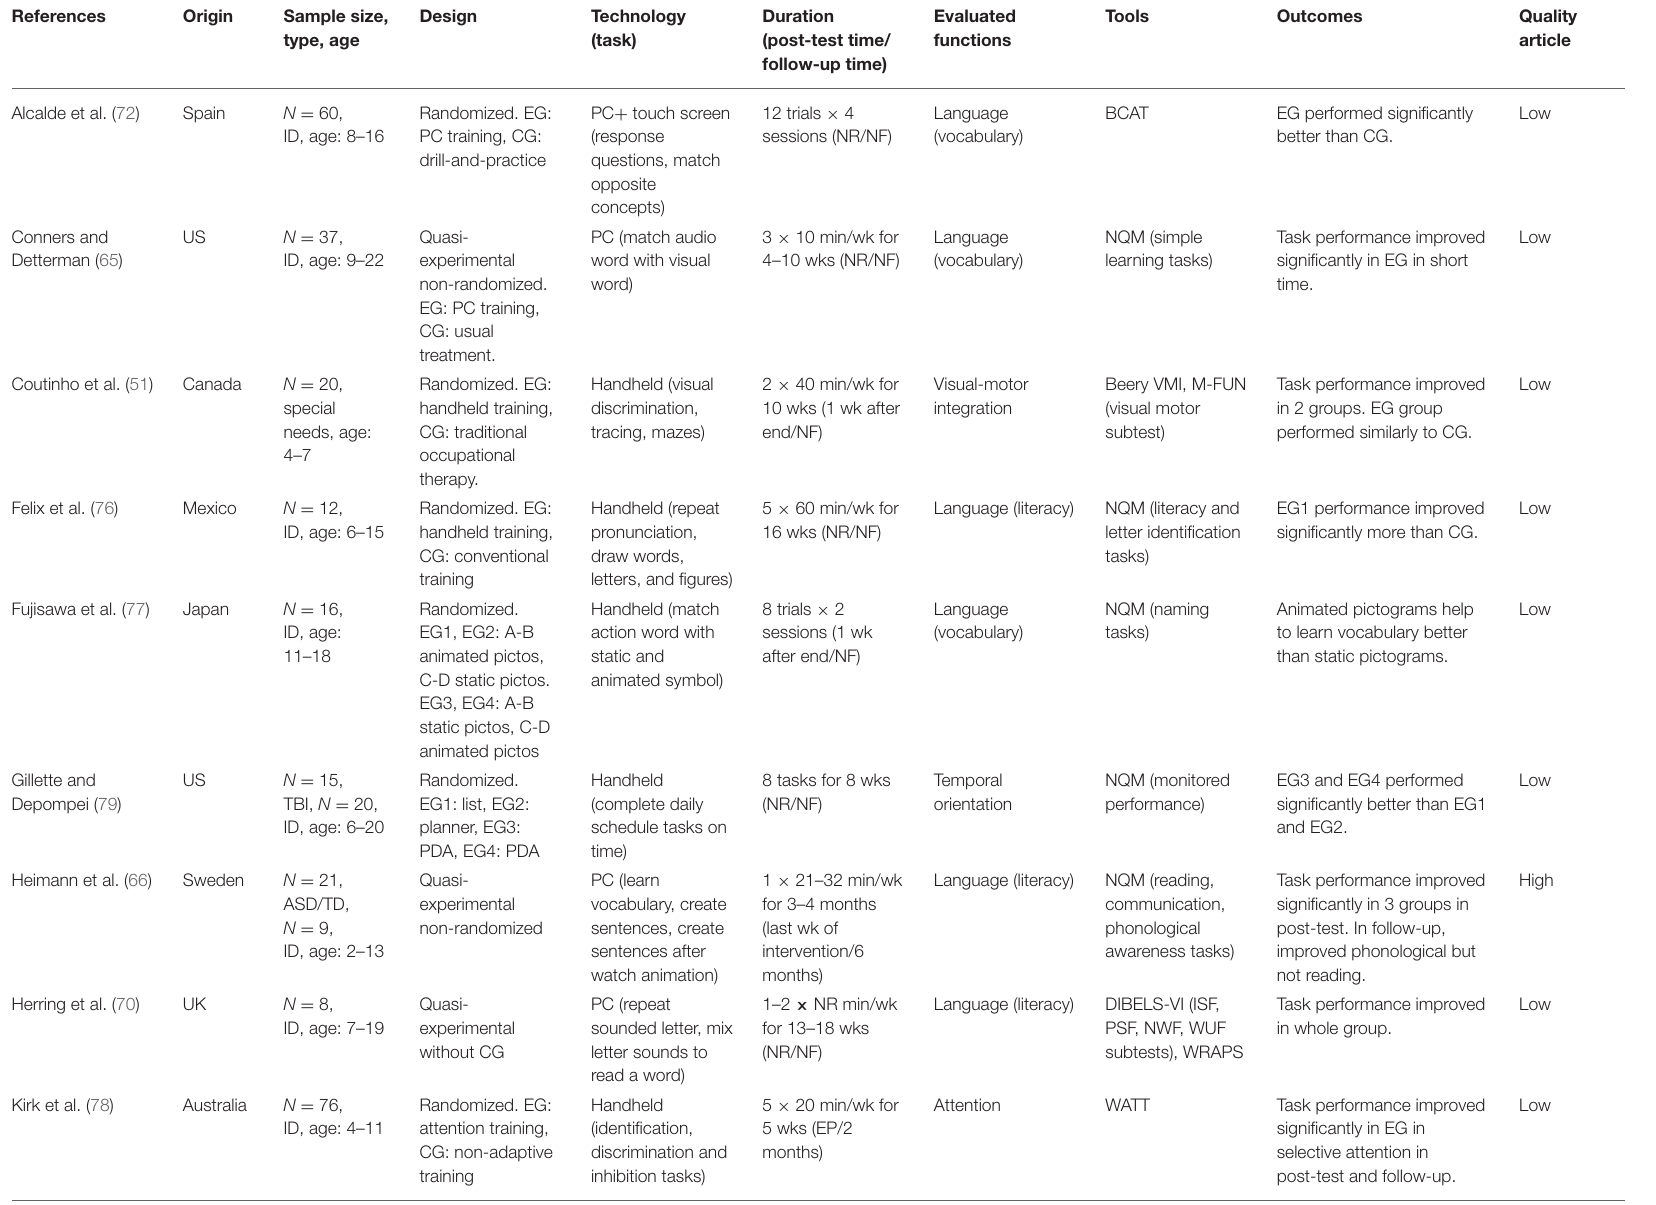
TABLE 3 | Reviewed studies focusing on basic cognitive